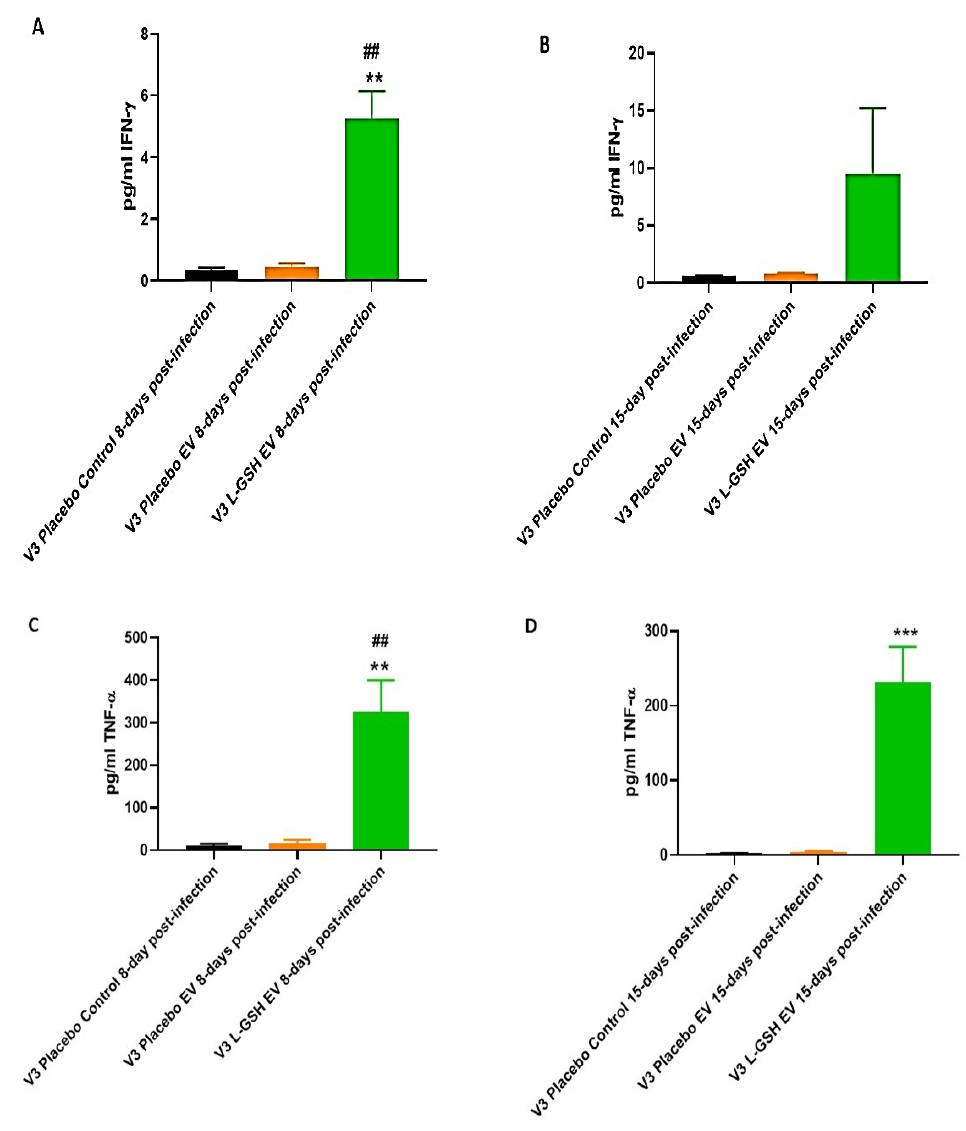
Figure 3A, B, C, D, E, F, G, H: Clinical trial findings from in vivo and in vitro studies. Quantification of IFN-γ, TNF-α, IL-2 and IL-6 in the in vitro granulomas of T2DM subjects on L-GSH/or placebo supplement. PBMCs isolated from individuals with type 2 diabetes at pre-